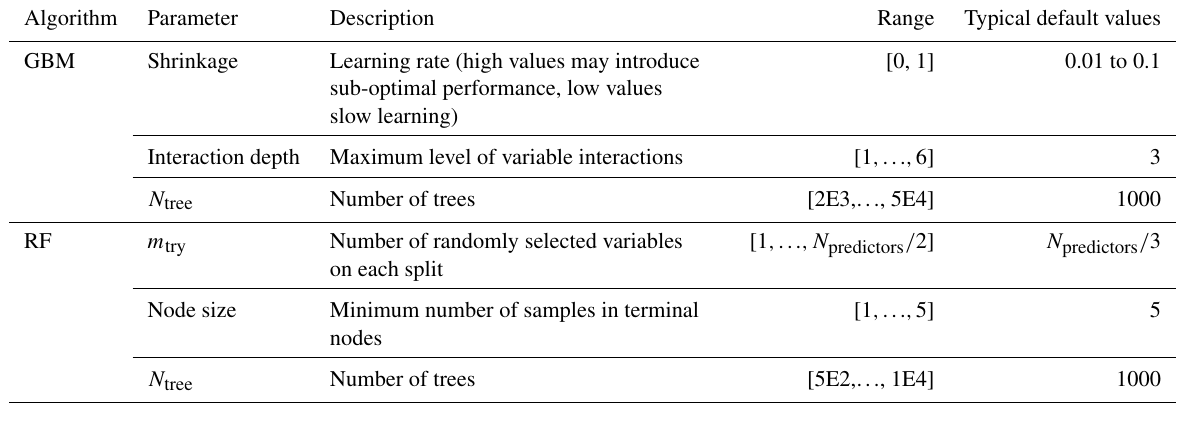
Table 3. Range of the hyper-parameters used in the calibration for gradient-boosting machines (GBMs) and random forests (RFs). The calibration routine searches for the optimal parameter values within the prescribed ranges. Typical default values for the GBM from Greenwell et al. (2020) and RF from Probst et al. (2019). The final calibrated hyper-parameters are presented in Table